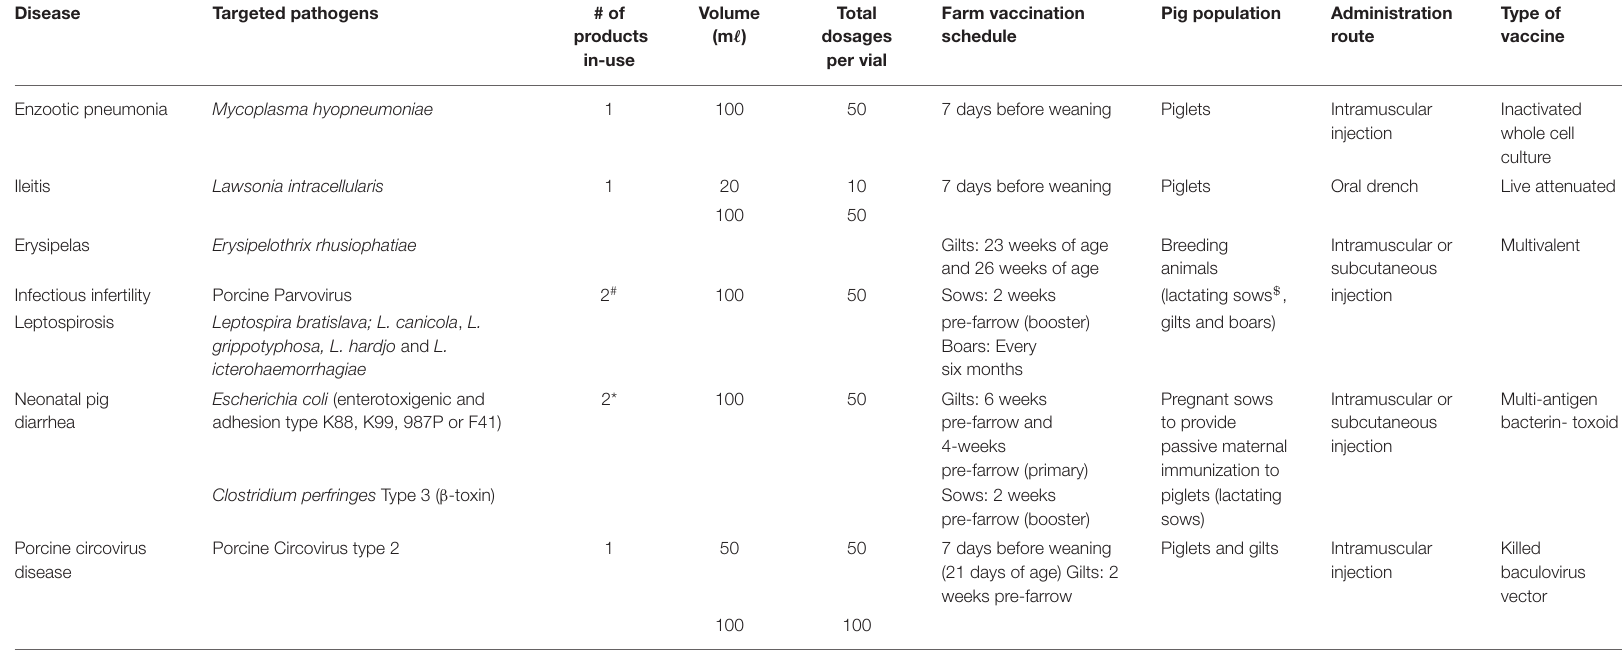
TABLE 3 | Summary of vaccines used on a commercial pig farm over a three-year period (2016–2018) in South